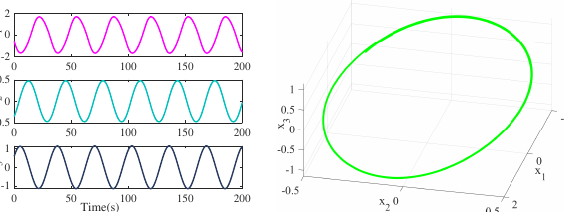
Figure 7. Stable periodic solution of triggering control systems without aperiodic DoS attacks.